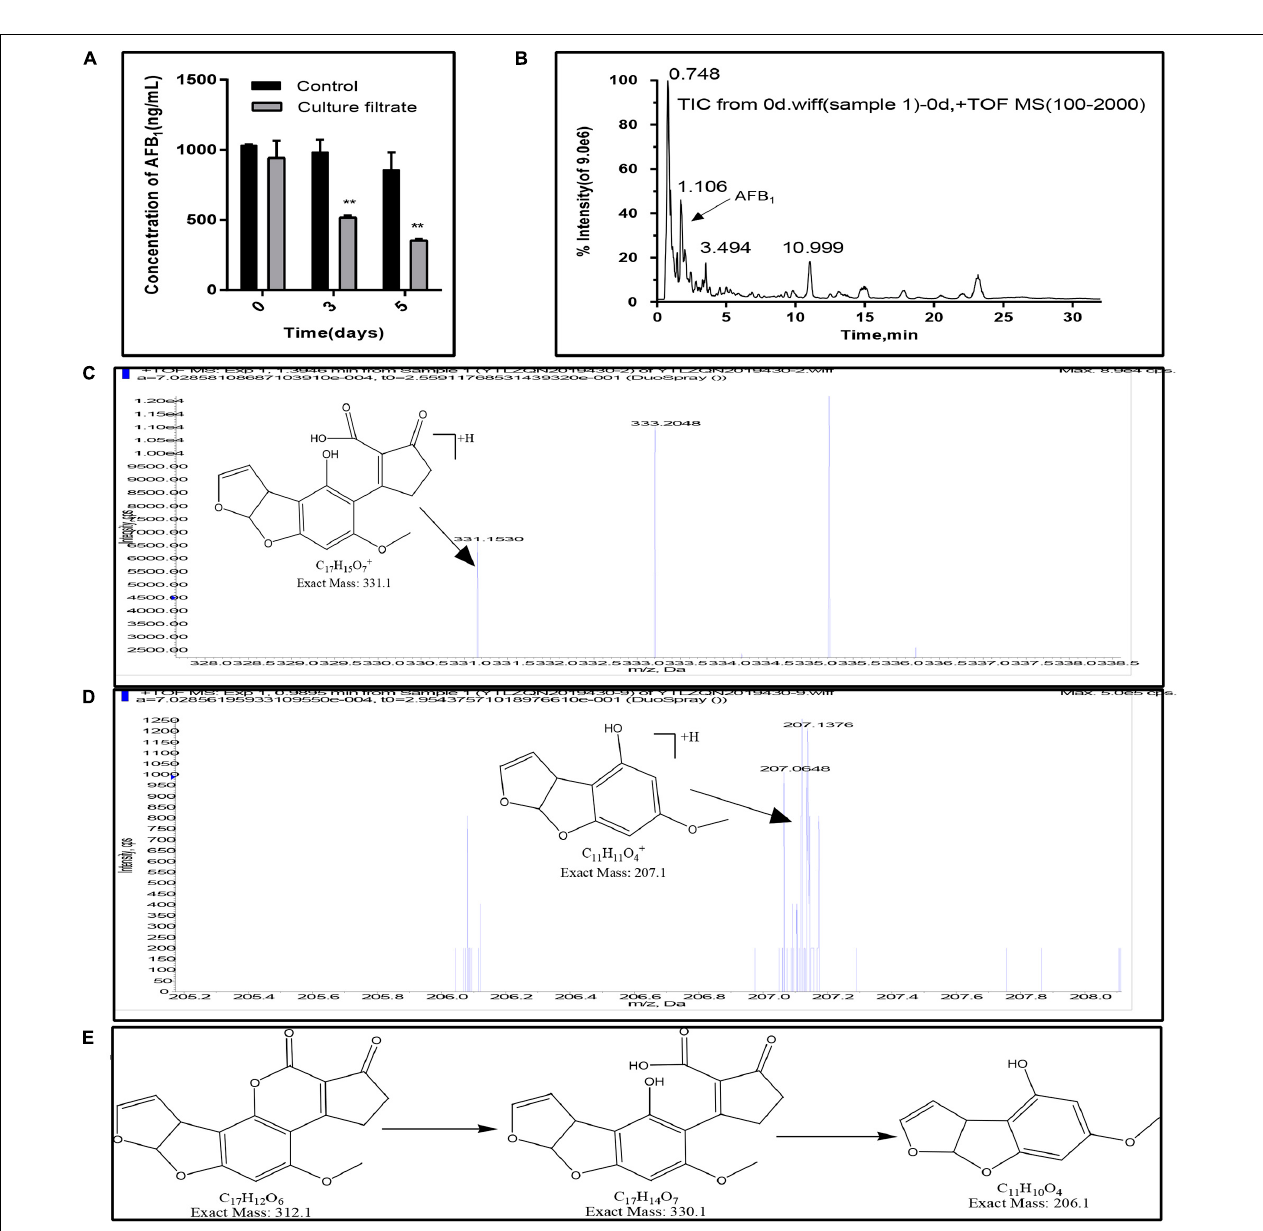
FIGURE 5 | AFB 1 degradation and fragmentation of biodegradation products of AFB 1 . (A) Residual aflatoxin B 1 (ng/mL) in the E. cristatum culture filtrate and PDB over different time-periods at 28 ± 2 ◦ C. Error bars represent standard deviations of the means following three replicates each. (B) Electrospray ionization (ESI) total ion chromatogram (TIC) scan of control group (1000 ng/mL AFB 1 in PDB broth, after incubation in the dark at 28 ± 2 ◦ C). (C) Putative degraded Product 1 . (D) Putative degraded Product 2 . (E) The deduced biodegradation pathway of AFB 1 .